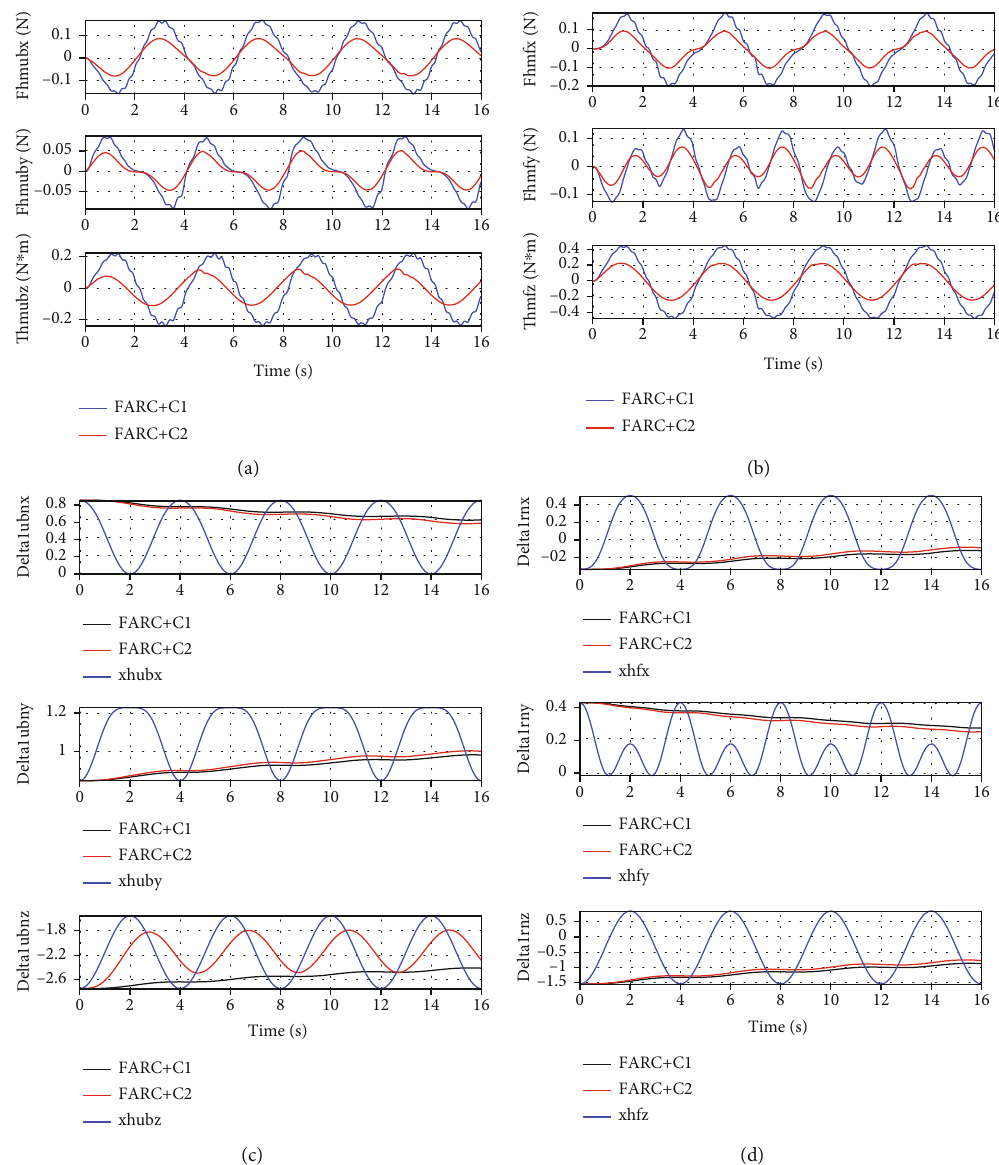
Figure 7: Simulation results of left leg support for Set2: (a) human-machine interaction force at the back, (b) human-machine interaction force at the right foot, (c) parameter estimation of Δ